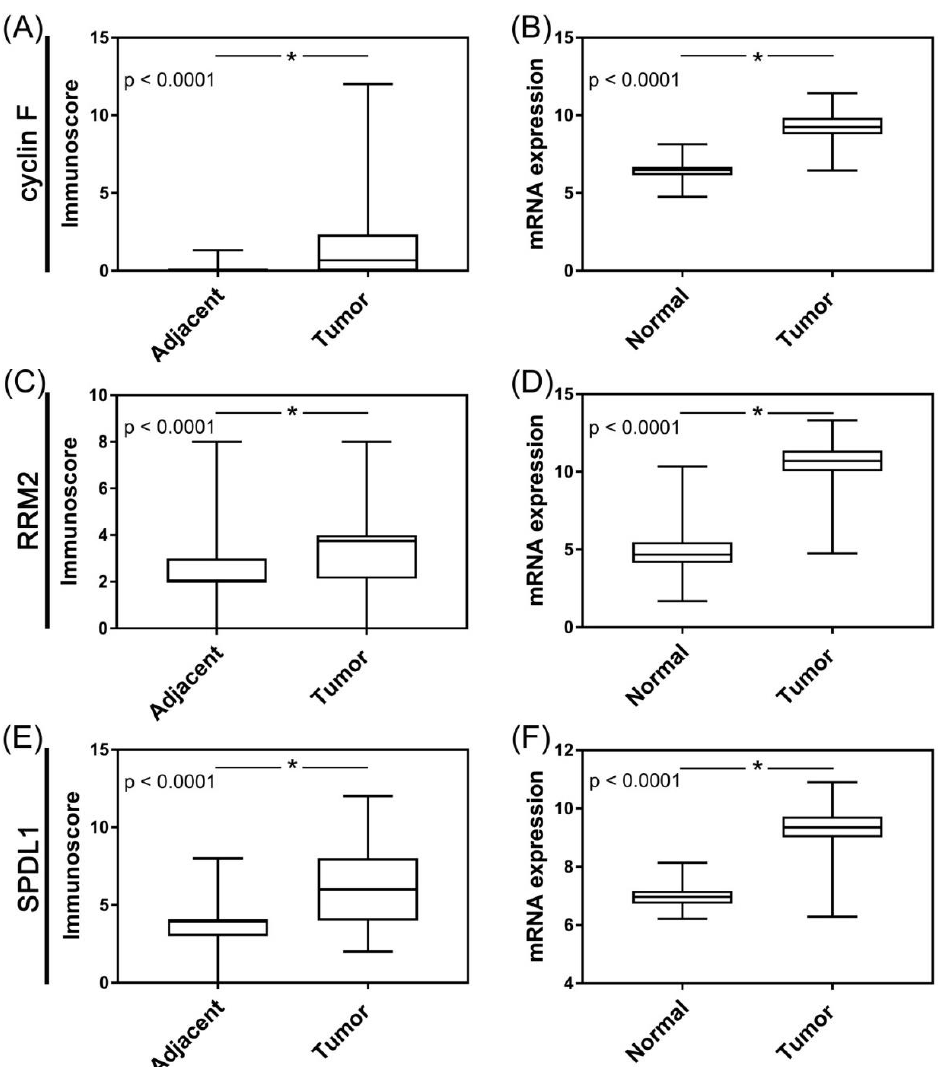
Figure 2. Protein and mRNA expression of cyclin F (CCNF), RRM2, and SPDL1 in pancreatic adenocarcinoma. ( A , C , E ) protein expression data were obtained by in-house immunohistochemistry; X axis of the plot represents histologically normal tissue that was adjacent to tumor tissue vs. cancer tissue, Y axis represents immunoscores (IRS). ( B , D , F ) mRNA expression data were retrieved from the Cancer Genome Atlas (TCGA); X axis of the plot represents normal vs. cancer tissue; Y axis represents normalized expression of mRNAs. The top and bottom of the error bars represent the maximum and minimum values of data, respectively. Asterisk indicates statistical significance ( p < 0.05, Mann–Whitney test).